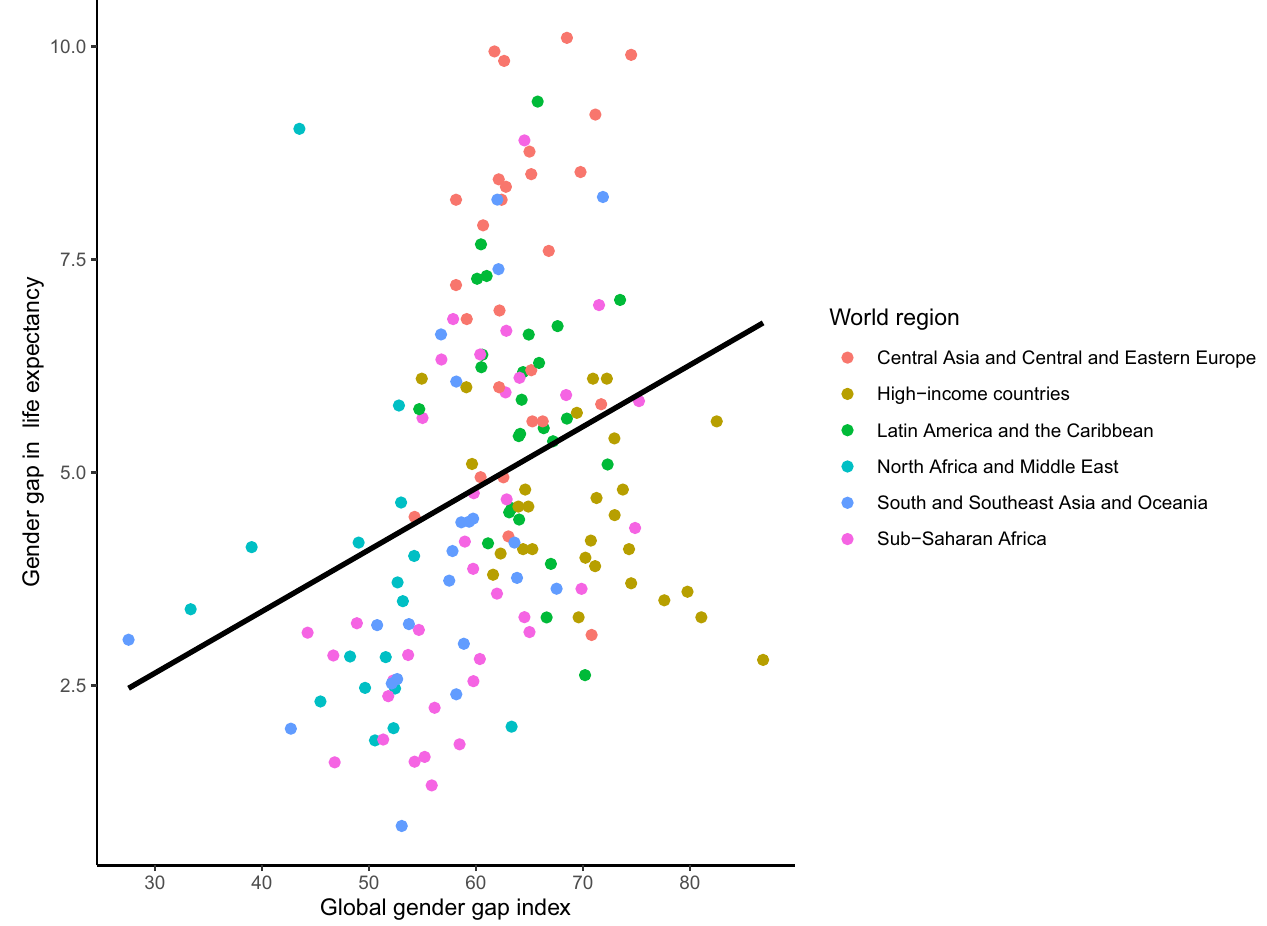
Fig 5. Cross-sectional association between the mGGGI and gender gap in life expectancy in 2020/1. The scatterplot displays the linear regression line for the association between the mGGGI and the gender gap in life expectancy (0.72 [0.37 to 1.07], p-value < 0.001).